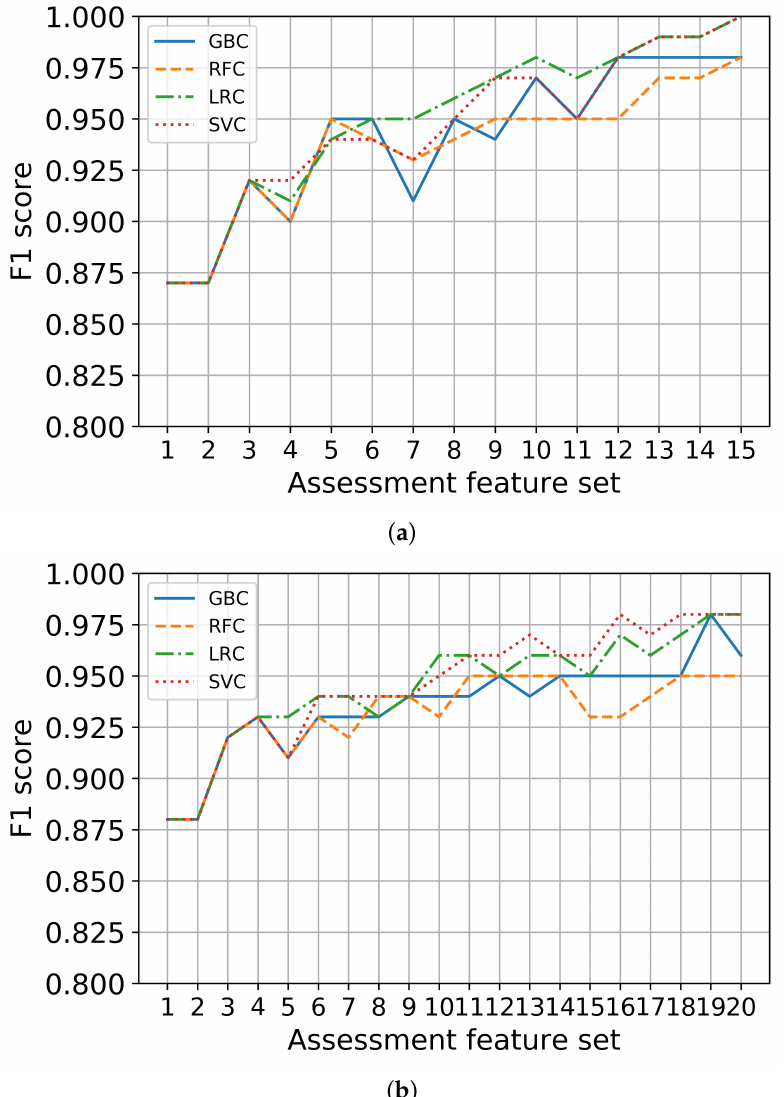
Figure 3. Binary classification performance using only assessment feature sets. ( a ) Depression, ( b )